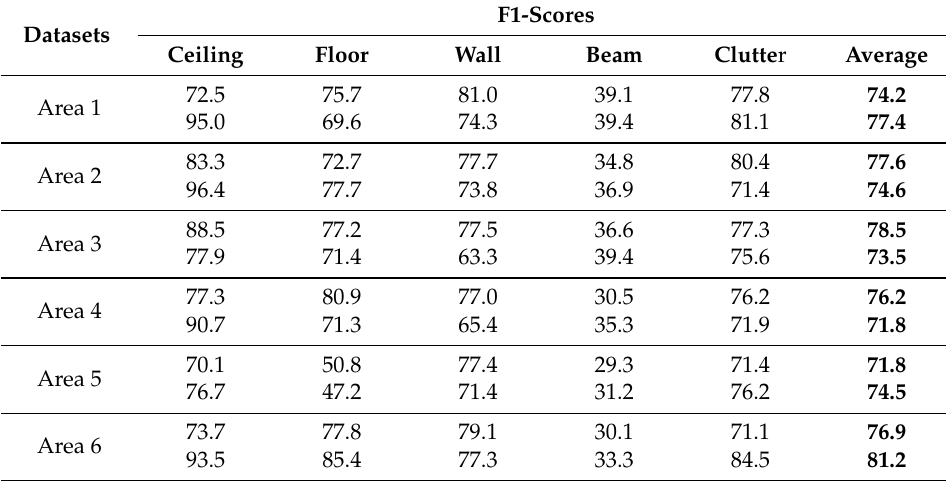
Table 8. F1-scores of the point-based (top row) and mesh-based (bottom row) classification of the 2D-3D-Semantics Dataset of Stanford